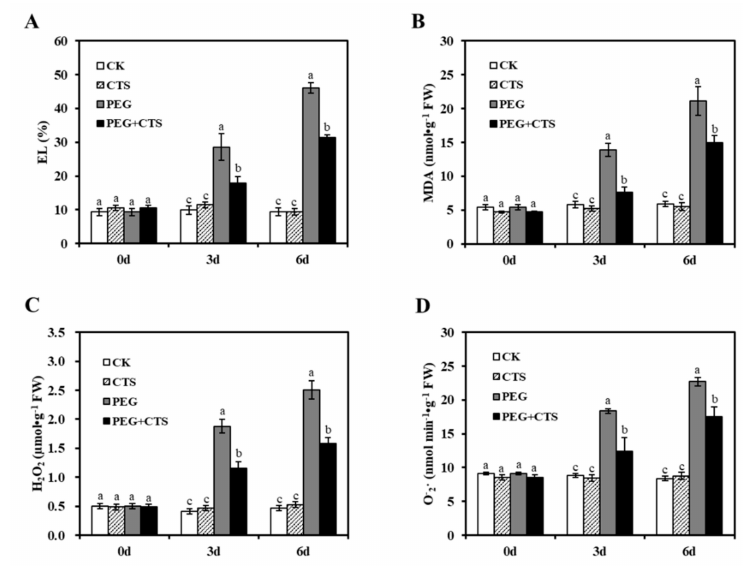
Figure 2. E ff ect of chitoscan (CTS) pre-treatment on changes of annual ryegrass EL value ( A ), MDA − · content ( D ) before and after osmotic stress treatment. Vertical content ( B ), H 2 O 2 content ( C ), and O 2 bars represent mean values ± SD for each mean. Di ff erent letter indicates significant di ff erences at given day ( P ≤ 0.05).